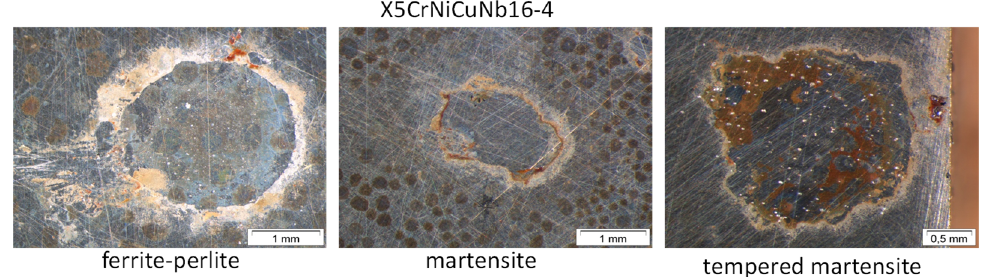
Figure 8. Sample surfaces (micro) of X5CrNiCuNb16-4 after 8000 h of exposure to water-saturated supercritical CO 2 at 60 °C and 100 bar.